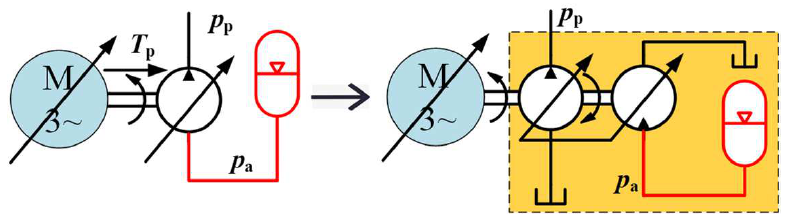
Figure 2. Working principle of the assisted starting concept.